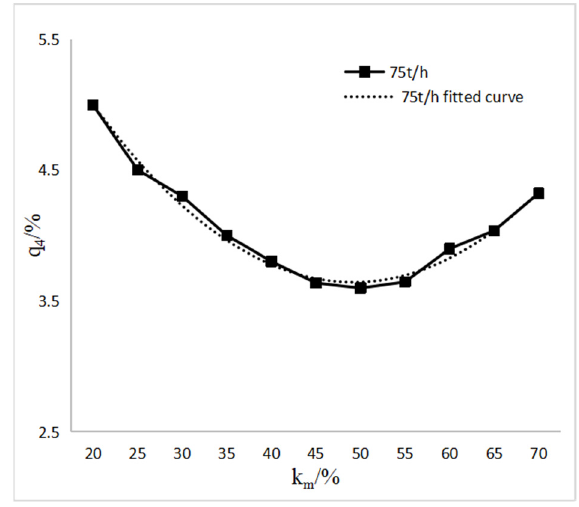
Figure 11. Influence of k m on q 4 .